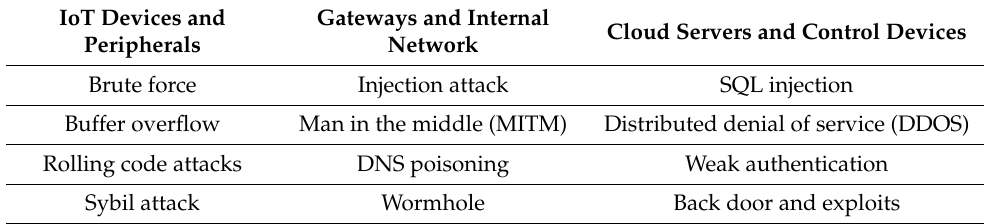
Table 1. Internet of Things (IoT)